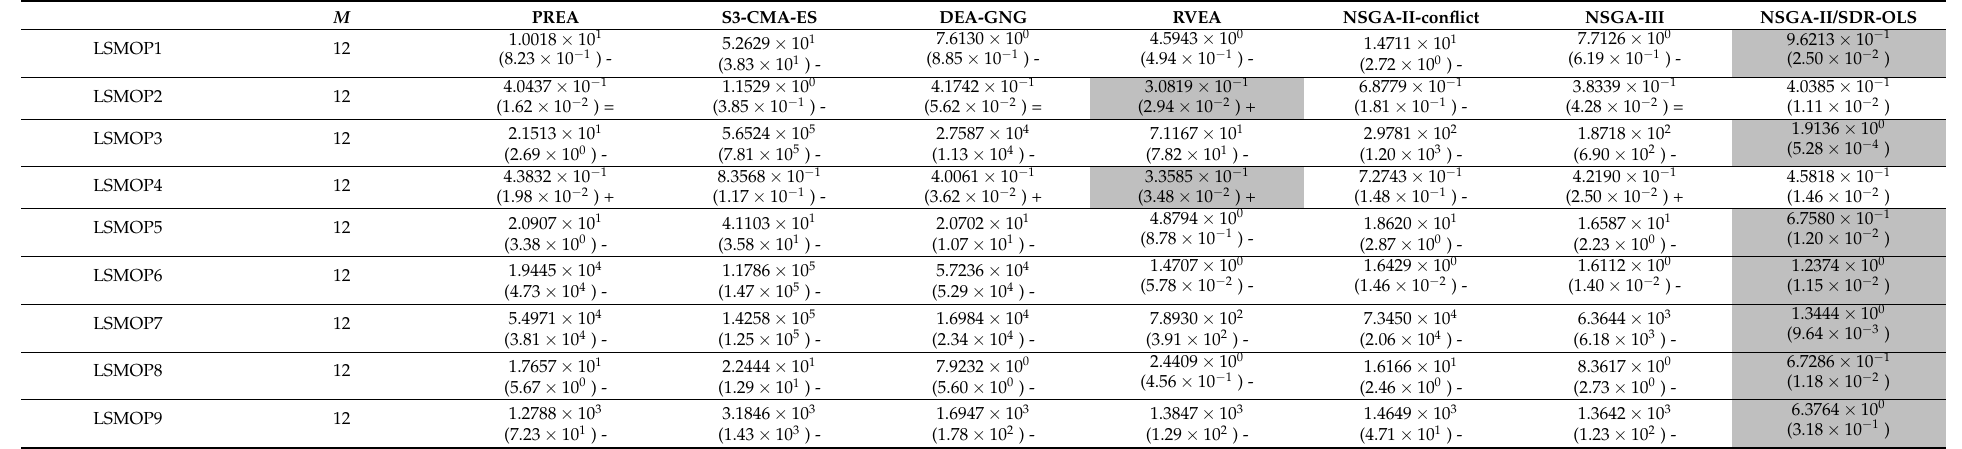
Table 14. IGD values for 9 twelve-objective benchmark problems.